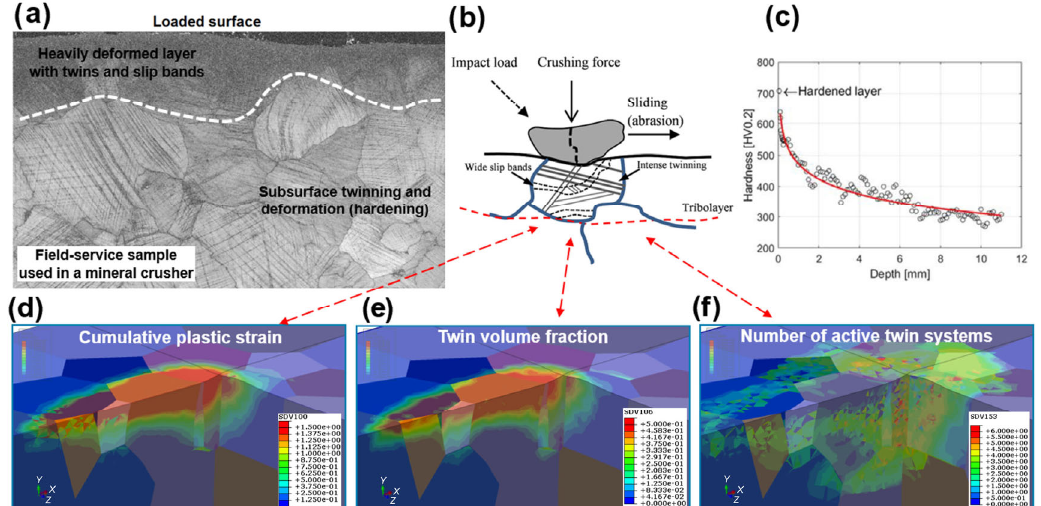
Fig. 7 (a) Cross-section of field-service sample, (b) schematic of surface deformation, (c) cross-section hardness gradient, reproduced from [36], (d) cumulative plastic strain (red color is 0.8), (e) twin volume fraction (red is 0.5), and (f) number of currently active twin systems (red is